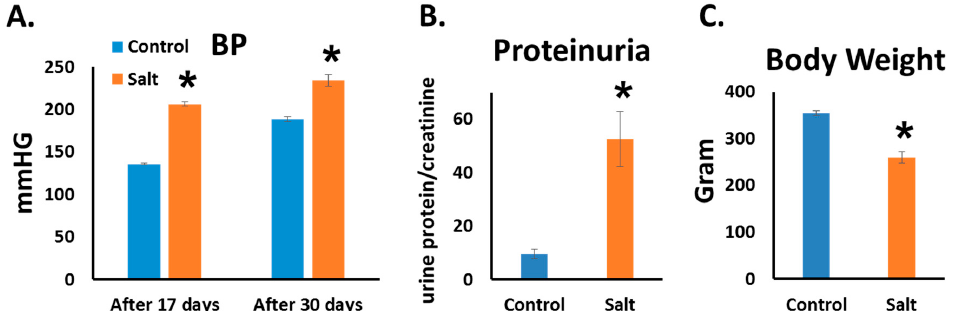
Figure 1. High salt diet (HSD)-fed rats developed hypertension accompanied by kidney injury. Blood pressure (BP) was measured using tail cuff. (The results of the 2nd and 5th weeks are shown.) ( A ) Proteinuria was measured in rat's urine at the end of the 8th week; ( B ) Body weight was measured at the end of the experiment (the 8th week); ( C ) n = 8–10, * p ≤ 0.05.